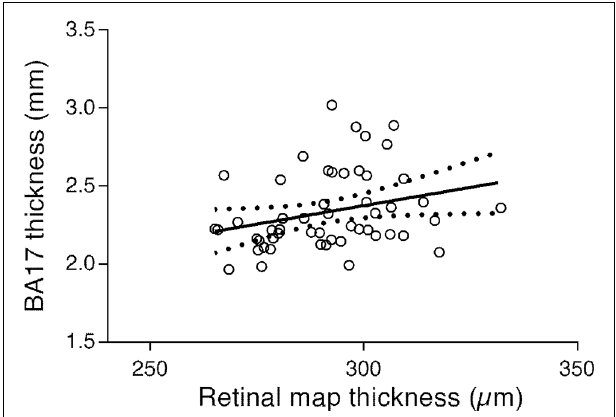
FIGURE 6 | Regression plot of the BA17 thickness vs. all lamina macular thickness and 95% confidence of the regression slope ( Y = 0.004687 × X + 0.9676; r = 0.277; p <